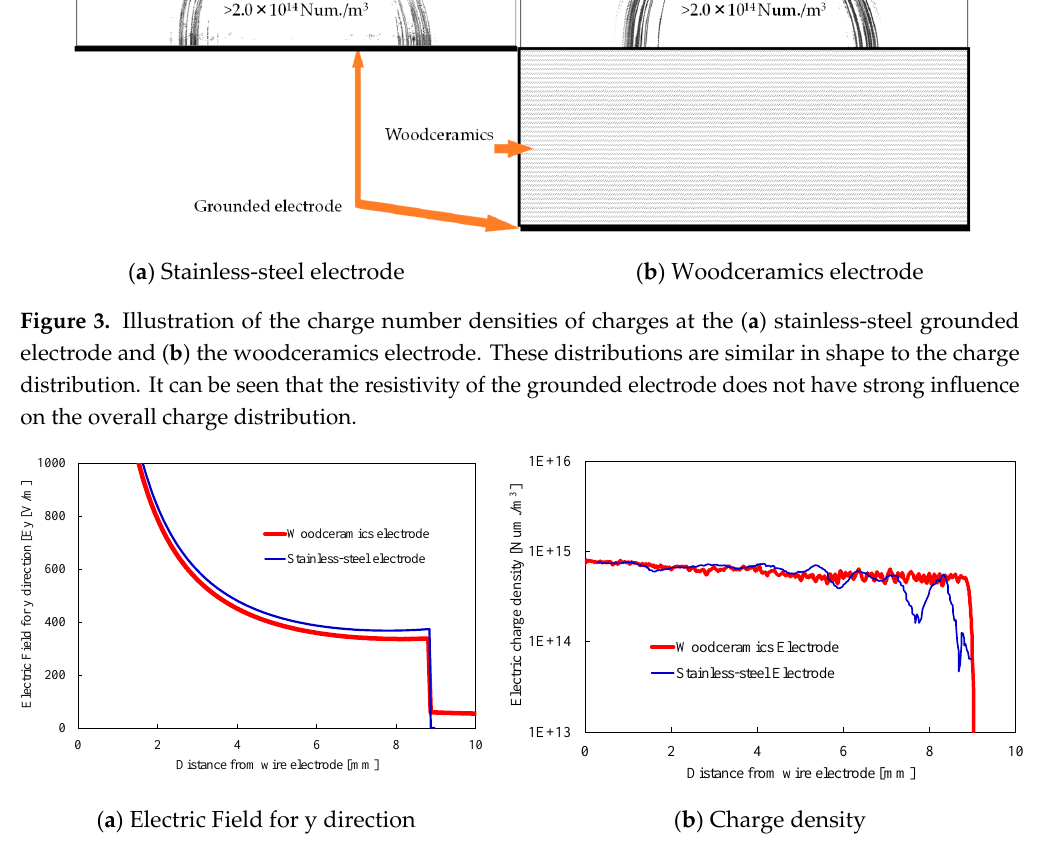
Figure 4. ( a ) Electric field in the y direction and ( b ) charge density between the wire electrode and grounded electrode. The horizontal axes represent the distance from the wire electrode. With the woodceramics electrode, the electric field decreased by 10% and the charge density was slightly lower than that with the stainless-steel electrode.